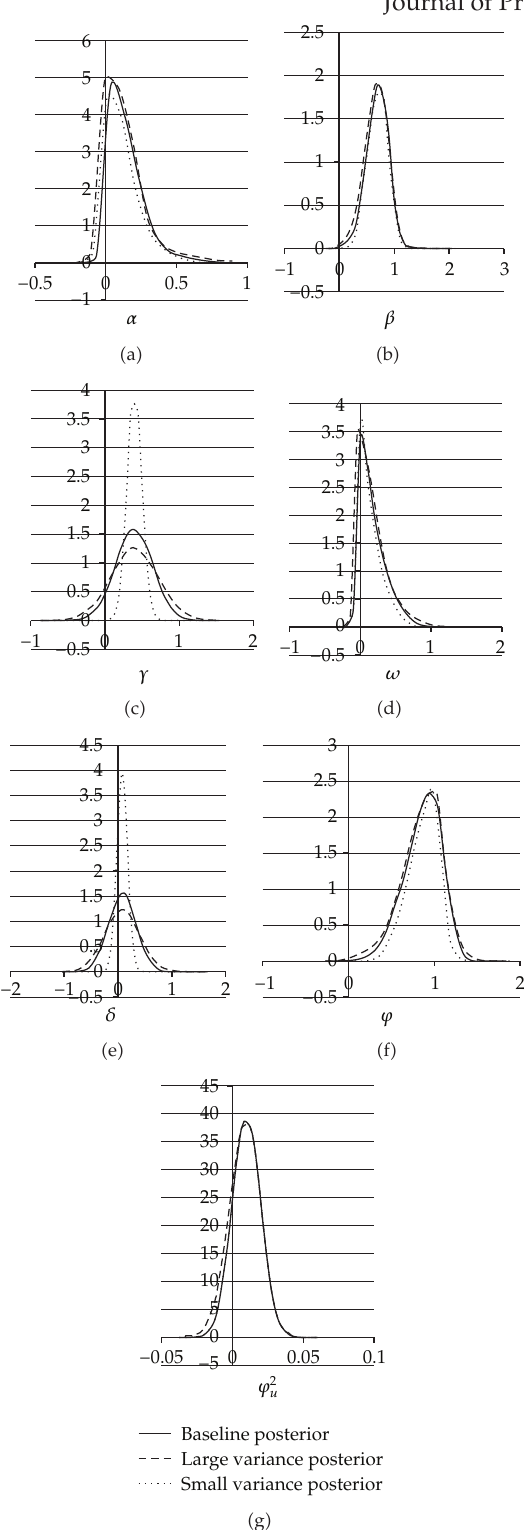
Figure 2: FTSE: posterior density estimates and sensitivity